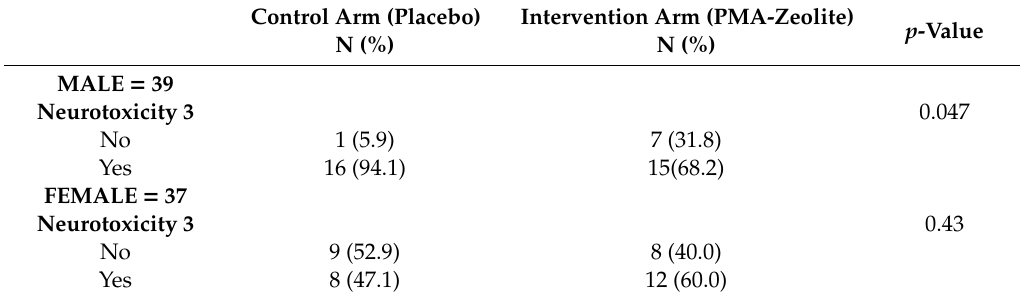
Table 4. Chemotherapy-induced peripheral neuropathy (CIPN) univariate analysis stratified by gender.